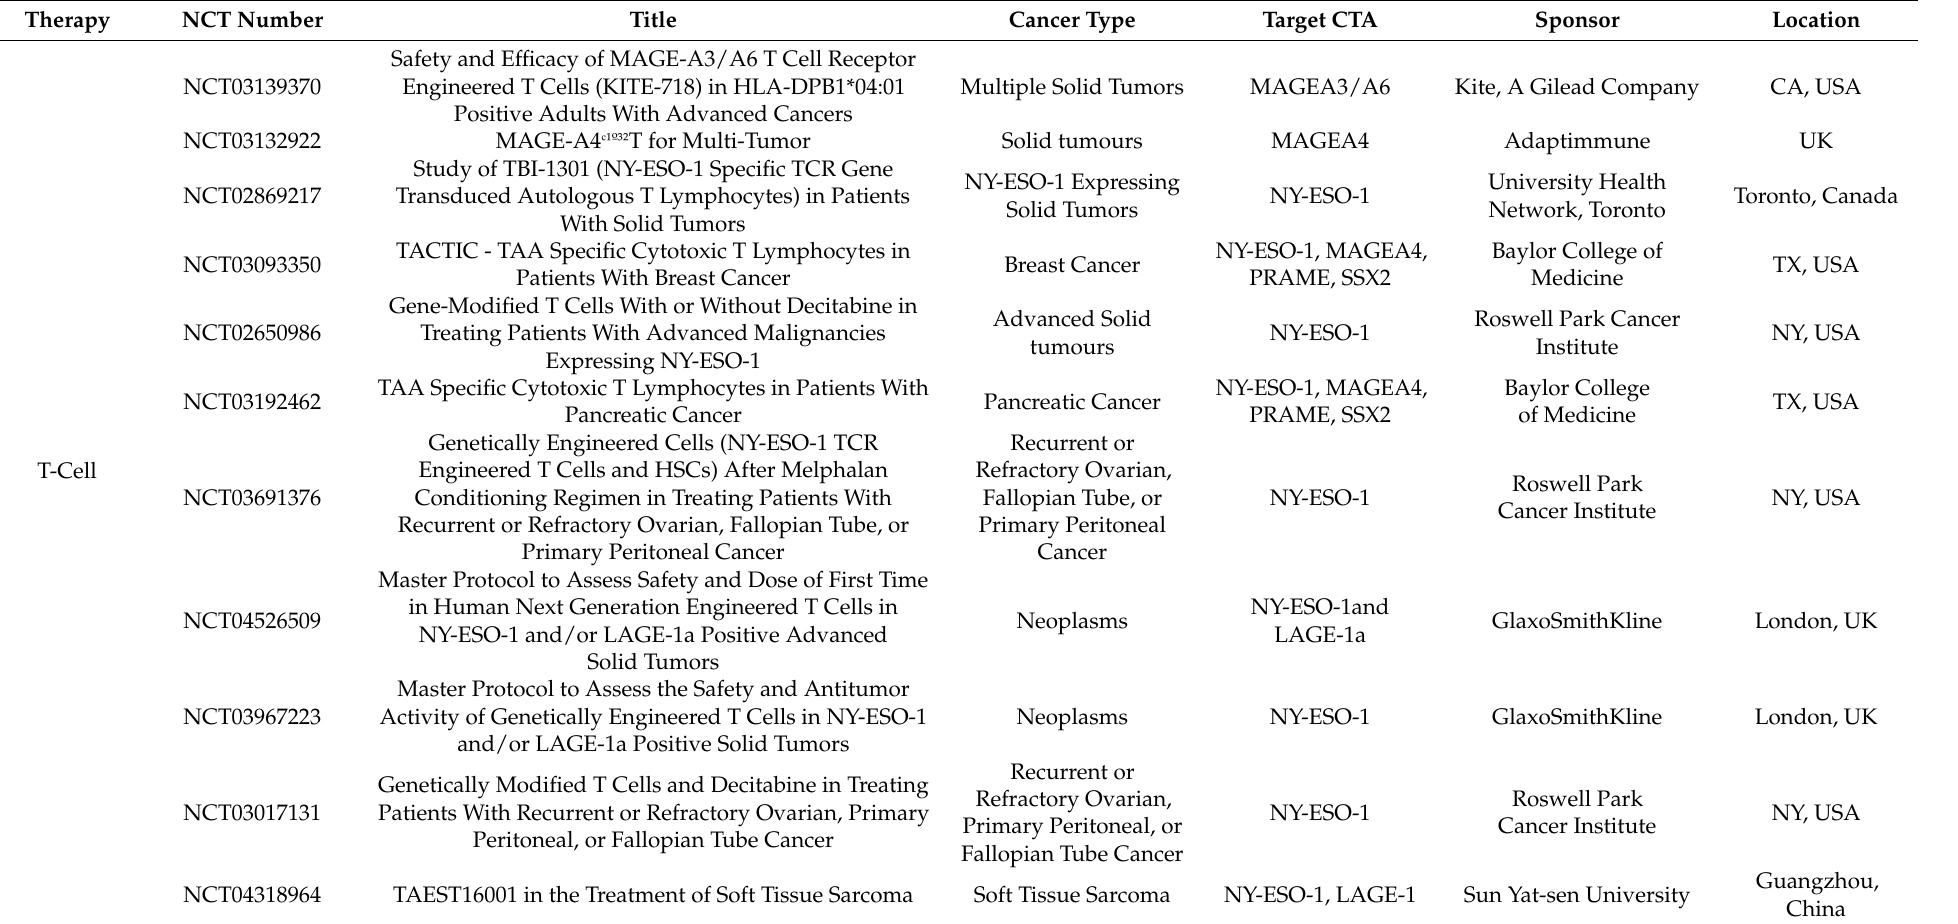
Table 2. List of currently active but not recruiting clinical trials targeting CTAs.